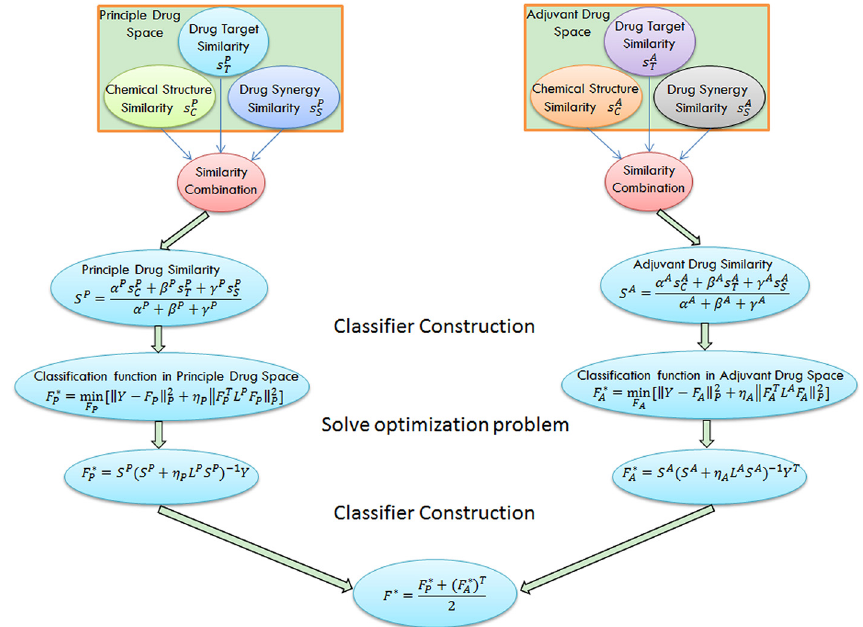
Fig 2. The basic idea of NLLSS is shown. First, the principal and adjuvant drug similarity are calculated based on drug chemical structure, drug-target interactions, and known synergistic drug combinations. Next, we construct the synergistic drug combination classifiers in the principal and adjuvant spaces, respectively. Finally, two classifiers are combined into the final classifier to select potential synergistic drug combinations for experimental validation.